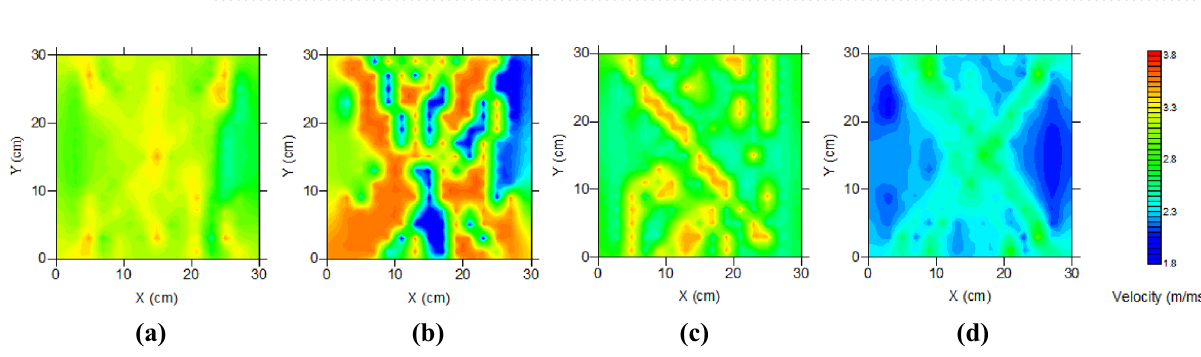
Figure 16. Blasting stress variation curves: ( a ) horizontal stress measurement points, and ( b ) vertical stress measurement points.